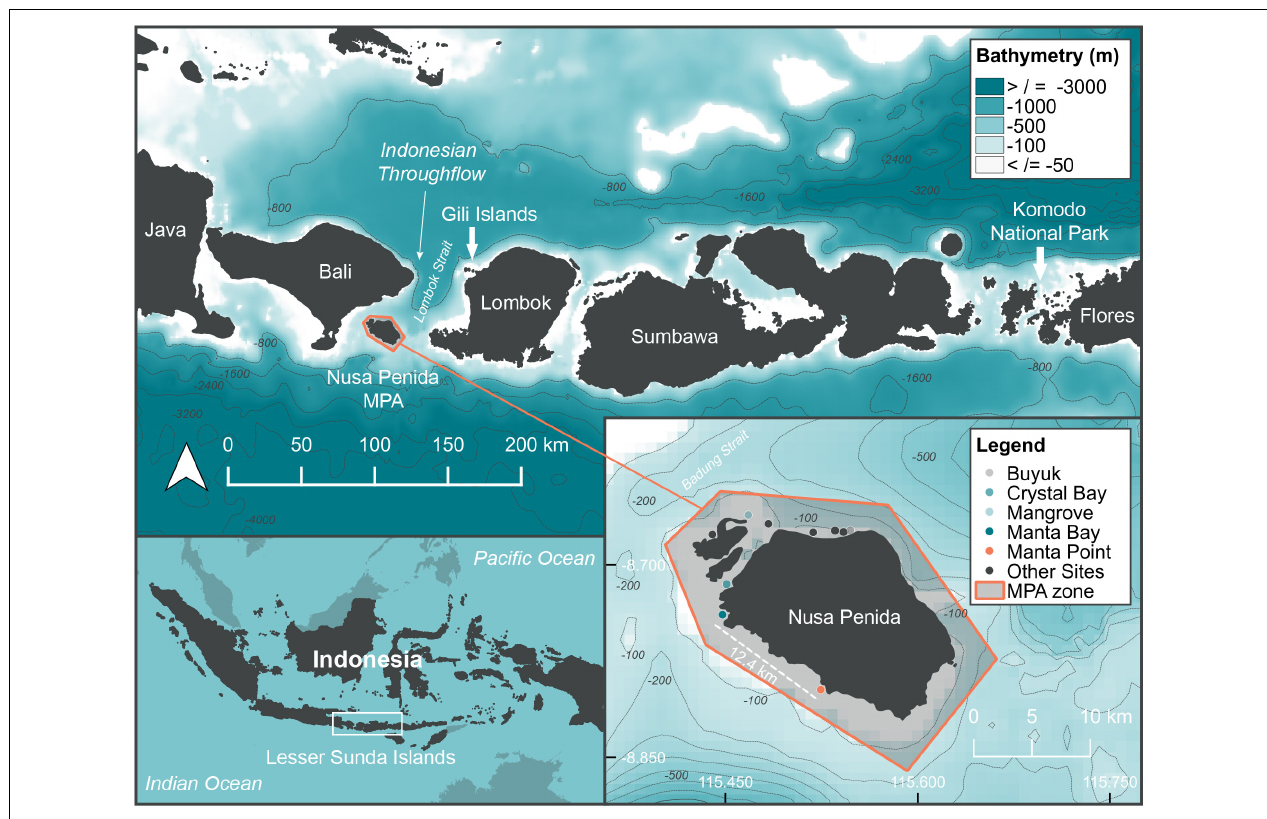
FIGURE 1 | Location of study sites in the Indonesian archipelago along the west coastline of Nusa Penida, Manta Bay (MB), and Manta Point (MP) shown in relation to Bali and the Lesser Sunda Islands, Indonesia. Popular SCUBA diving locations around the Nusa Penida MPA with infrequent manta ray sightings are also marked as described in the legend. Sites marked as “other” are ‘Pontoon,’ ‘Toyapakeh,’ ‘Sekolah Desa,’ ‘Pura Ped,’ ‘Sental,’ and ‘Pura Mas Gading.’ Bathymetry information was available from: GEBCO_2014 Grid, version 20150318;